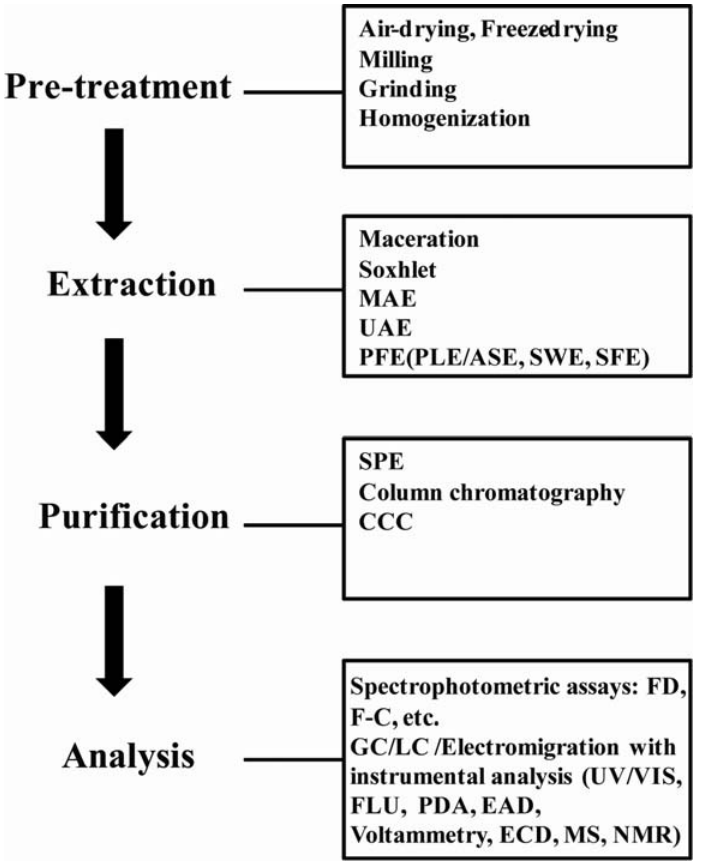
Figure 3. Strategies for preparation and characterization of phenolic samples from plant materials. Abbreviations: MAE, microwave-assisted extraction; UAE, ultrasound-assisted extraction; PFE, pressurized fluid extraction; PLE, pressurized liquid extraction; ASE, accelerated solvent extraction; SWE, subcritical water extraction; SFE, supercritical fluid extraction; SPE, solid phase extraction; CCC, countercurrent chromatography; FD, Folin- Denis method (FD), F-C, Folin-Ciocalteu method; GC, gas chromatography; LC, Liquid chromatography; FLU, fluorescence; PDA, photodiode array; EAD, electro-array detection; ECD, electrochemical detection; MS, mass spectrometric; NMR, nuclear magnetic